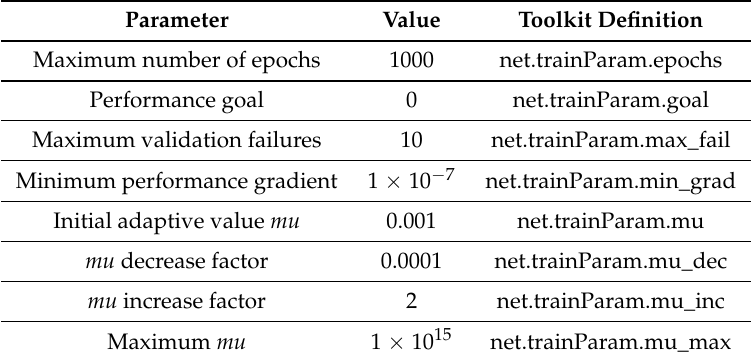
Table 1. Training parameters for the trainlm function defined in the Matlab toolkit.